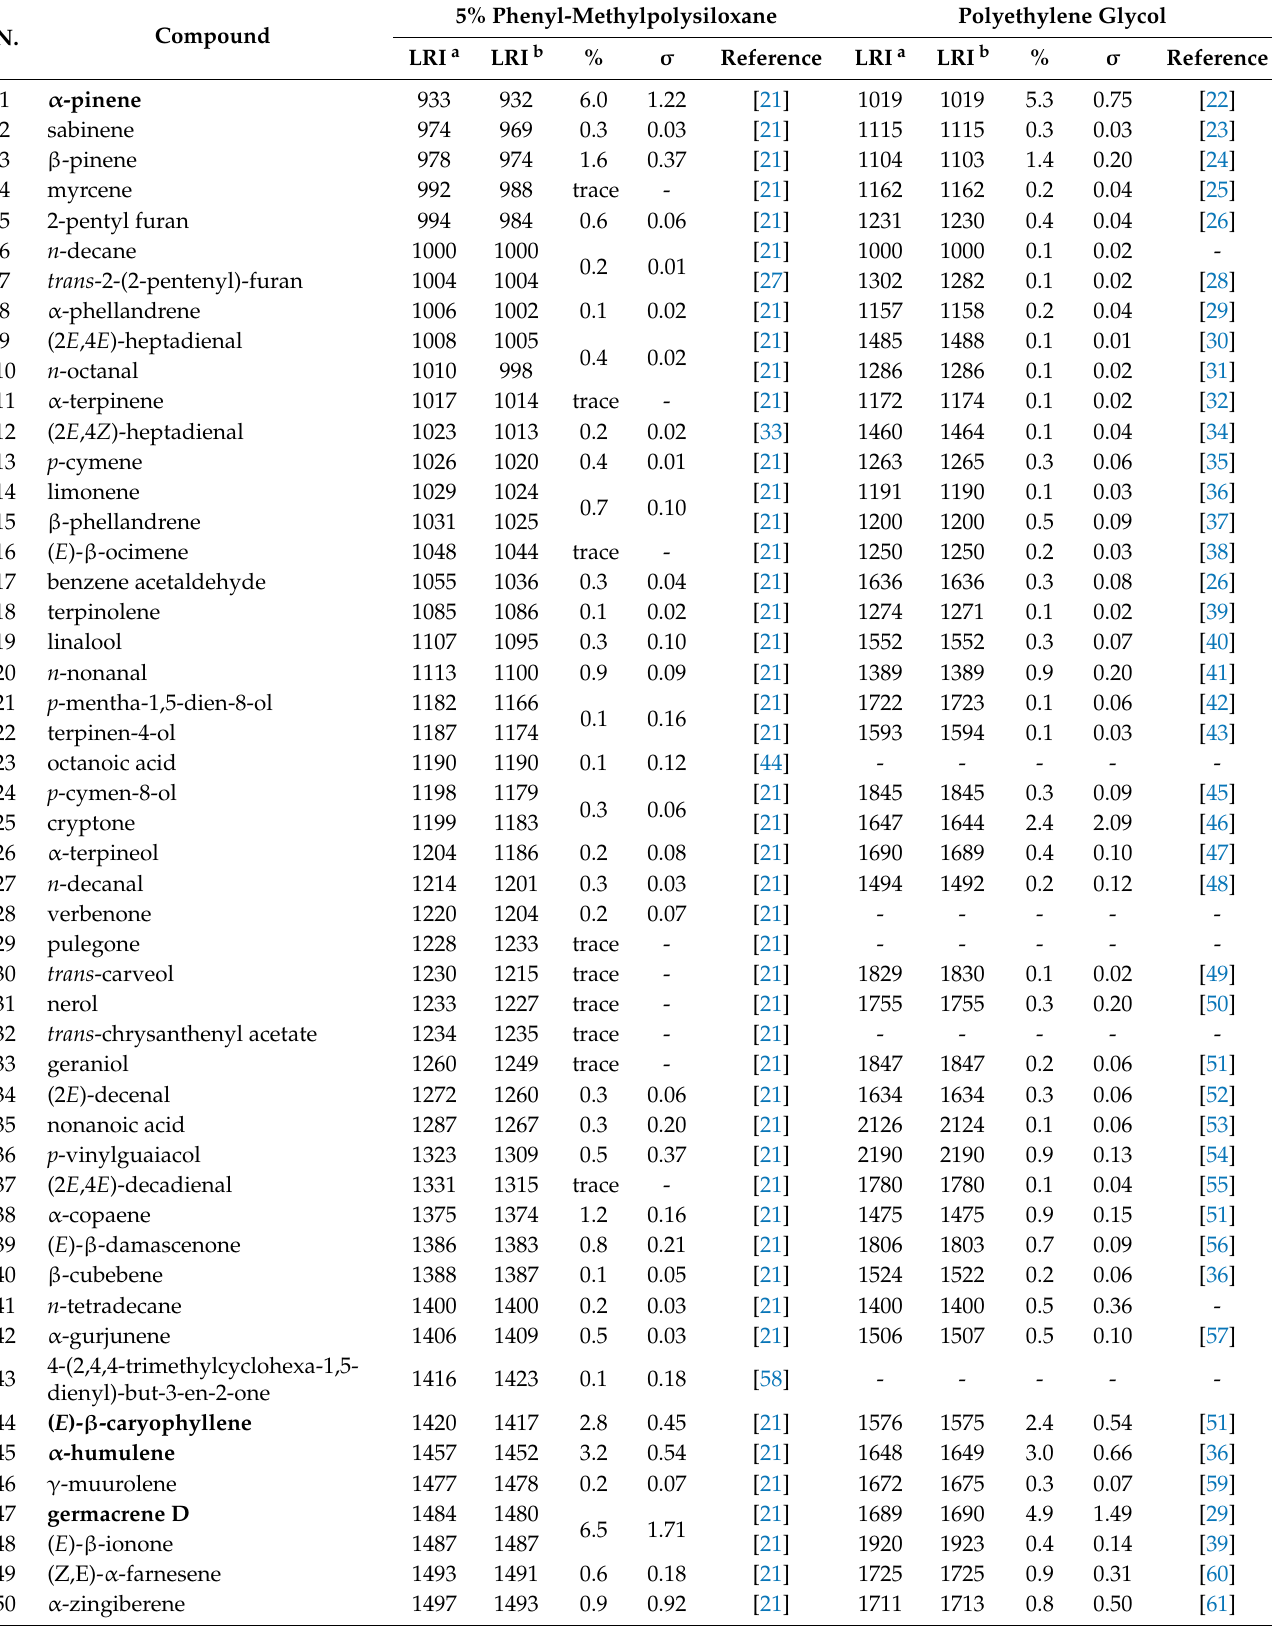
Table 1. Chemical composition of G. rugulosa EO through 5% phenyl-methylpolysiloxane and polyethylene glycol GC